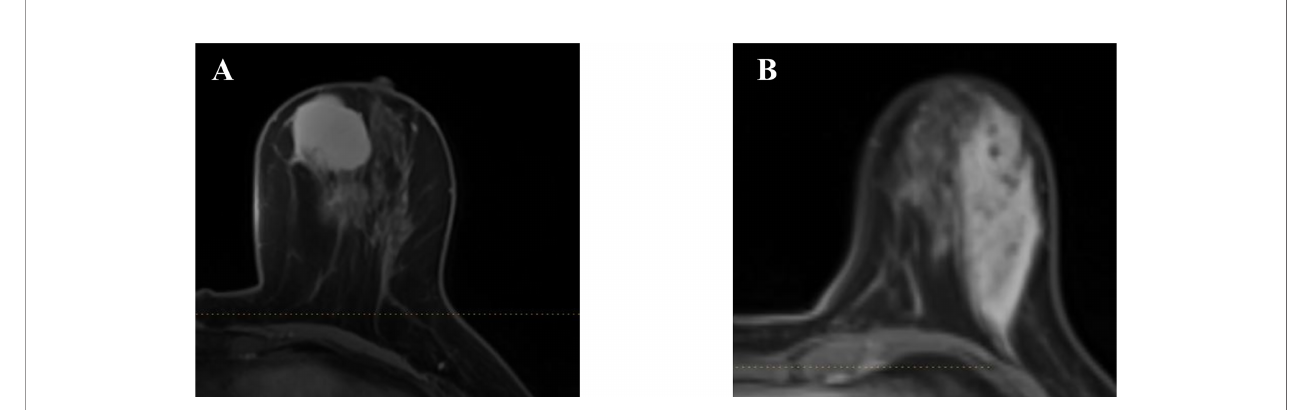
FIGURE 2 | Two examples of the axial plane of contrast-enhanced T1-weighted MR images. (A) Malignant breast lesions. (B) Benign breast